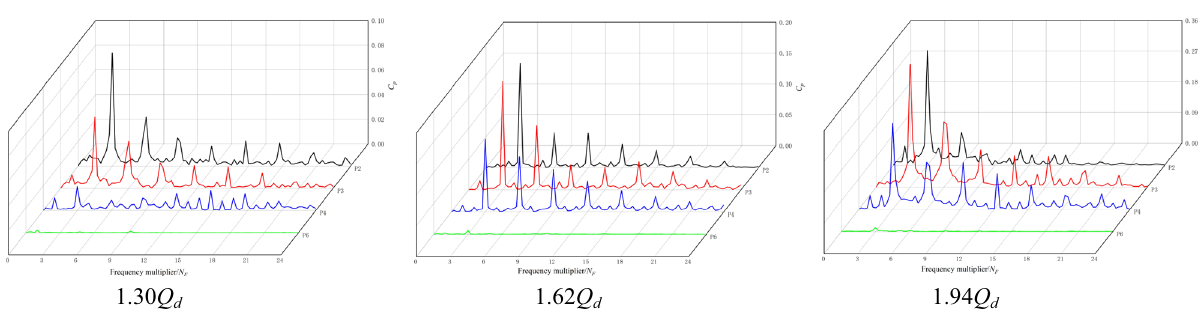
Figure 14. Frequency domain diagram of pressure fluctuation under